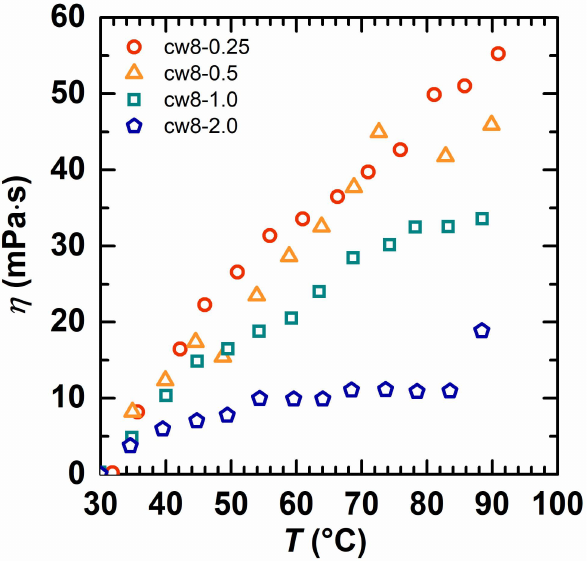
Figure 9. The reduced apparent viscosity as a function of temperature of HAPAM with different hy- drophobic monomer concentrations. The copolymer concentration was fixed at 1 wt% in all